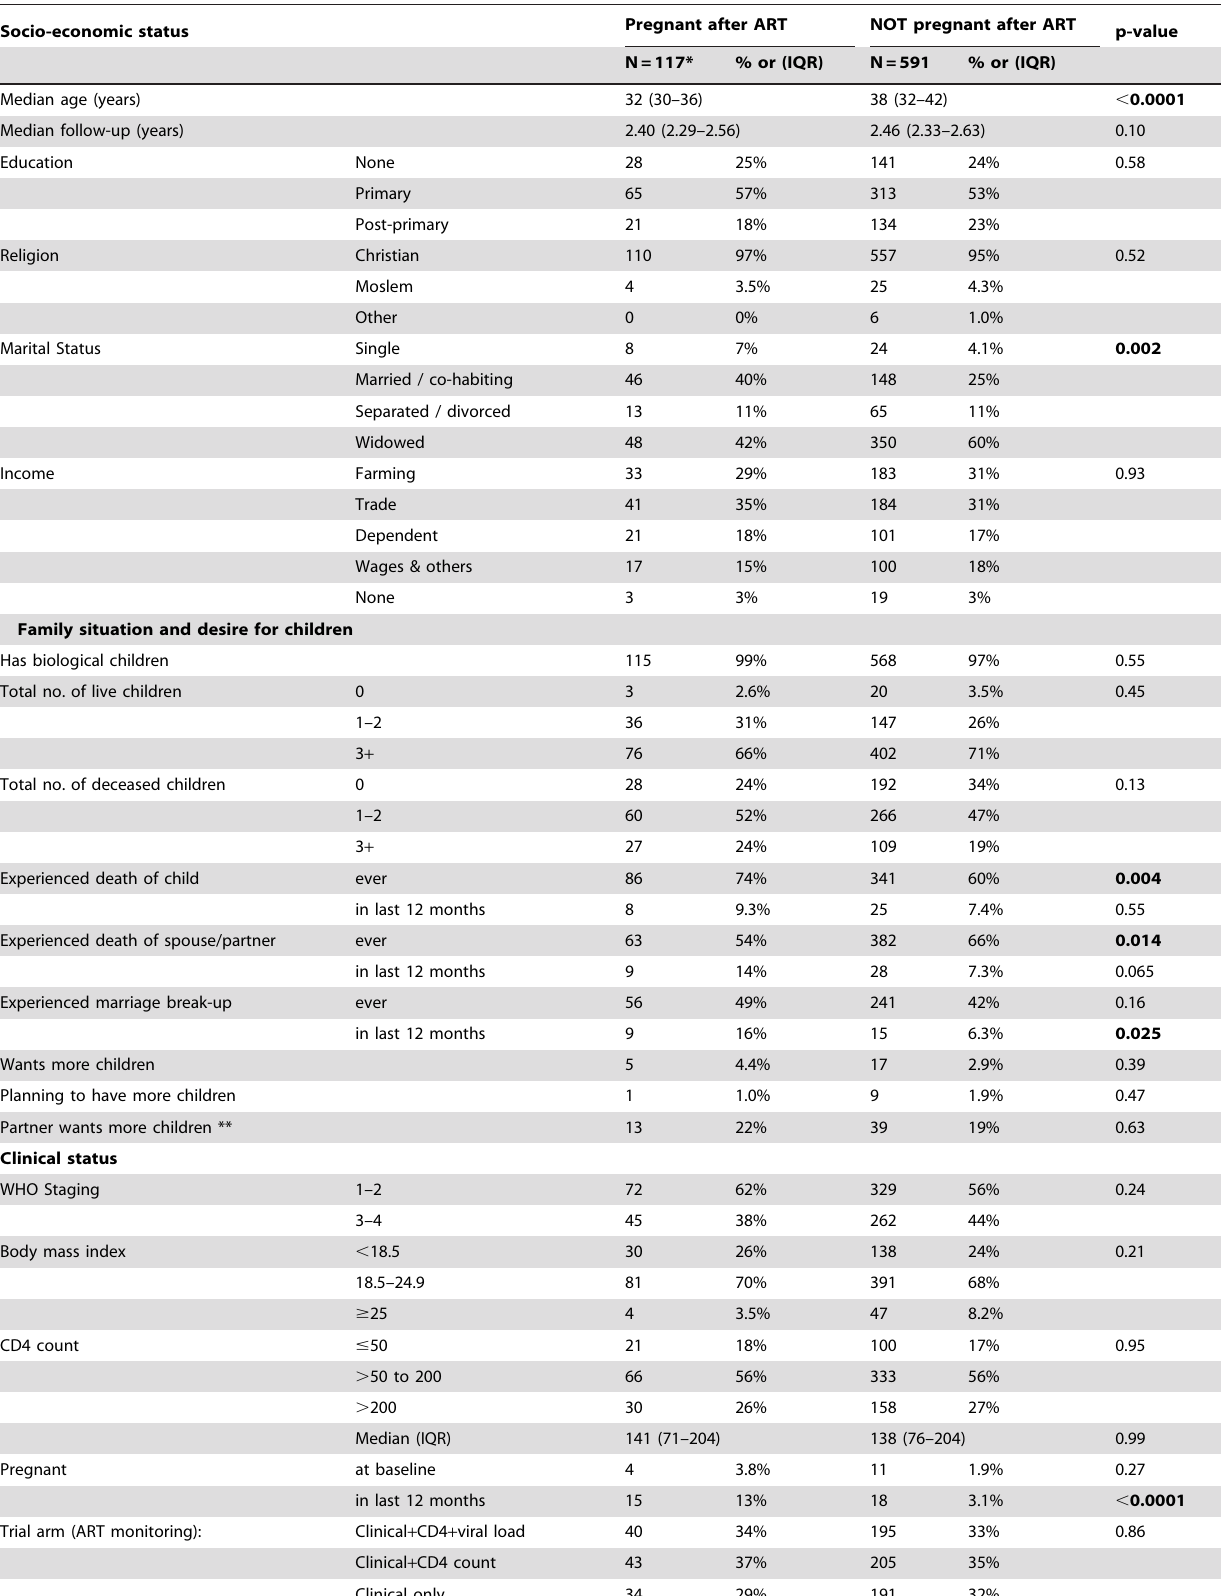
Socio-economic status Pregnant after ART